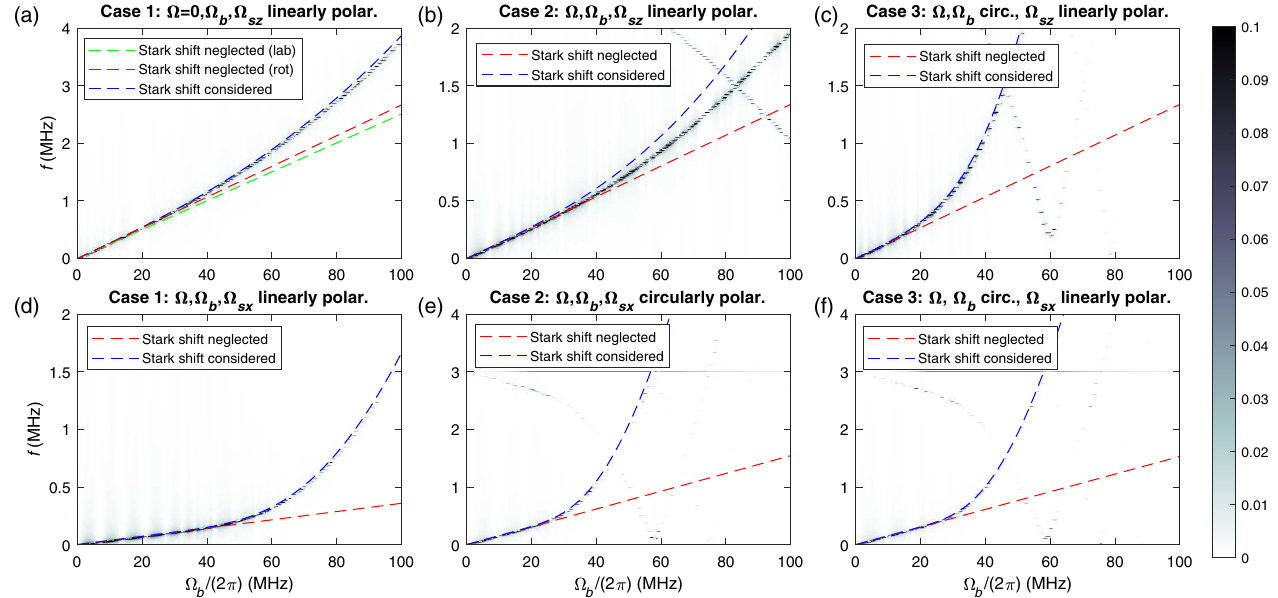
FIG. 9. Bias amplitude Ω b sweep simulation. The parameters are the same as in Fig. 6 except for the phase ϕ b ¼ π = 2 , initialization, and readout state jþi for panels (b) – (f), j 0 i for panel (a), and the bias amplitude Ω b being swept. The same resonance conditions are satisfied as in Fig. 7. We note that in panel (b), the theoretical prediction considering the ac Stark shift deviates from the simulation earlier than other curves. This may be due to the unconsidered three-frequency mixing of the counterrotating term of the resonant spin- locking driving with − 2 ω 0 , the counterrotating term of the bias ω b þ ω 0 , as well as the signal − ω s , which does not exist when both bias and resonant fields are circularly polarized in panel (c) or when Ω ¼ 0 in panel